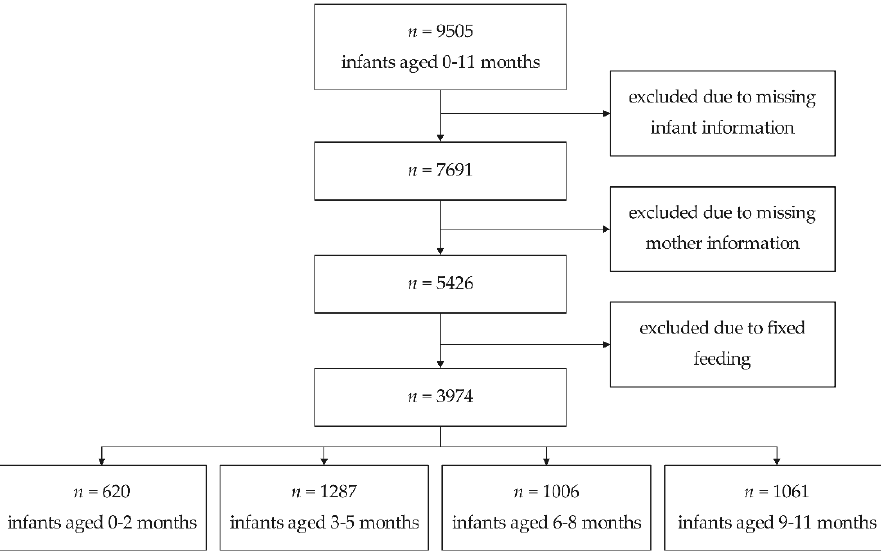
Figure 1. Flowchart of study participants selection.